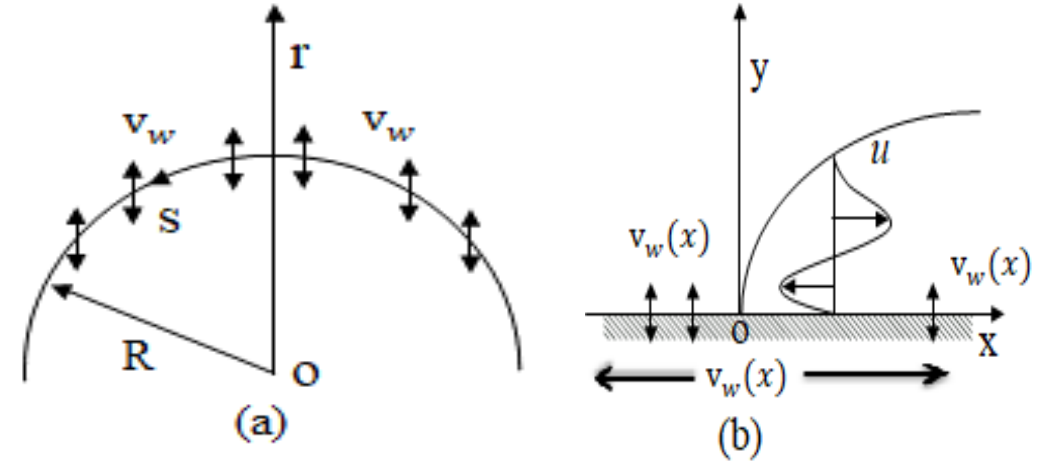
Figure 1. : Physical model and coordinates system: (a) curvature surface; (b) stretching surface. Figure 1. Physical model and coordinates system: ( a ) curvature surface; ( b ) stretching